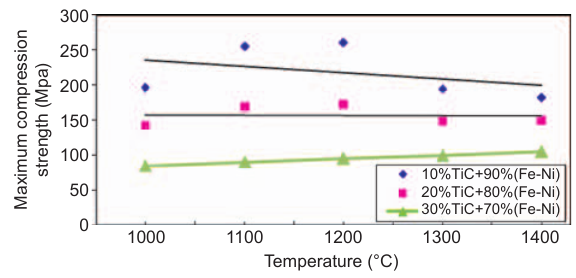
Figure 3 Maximum compression strength (MPa) against sintering temperature.